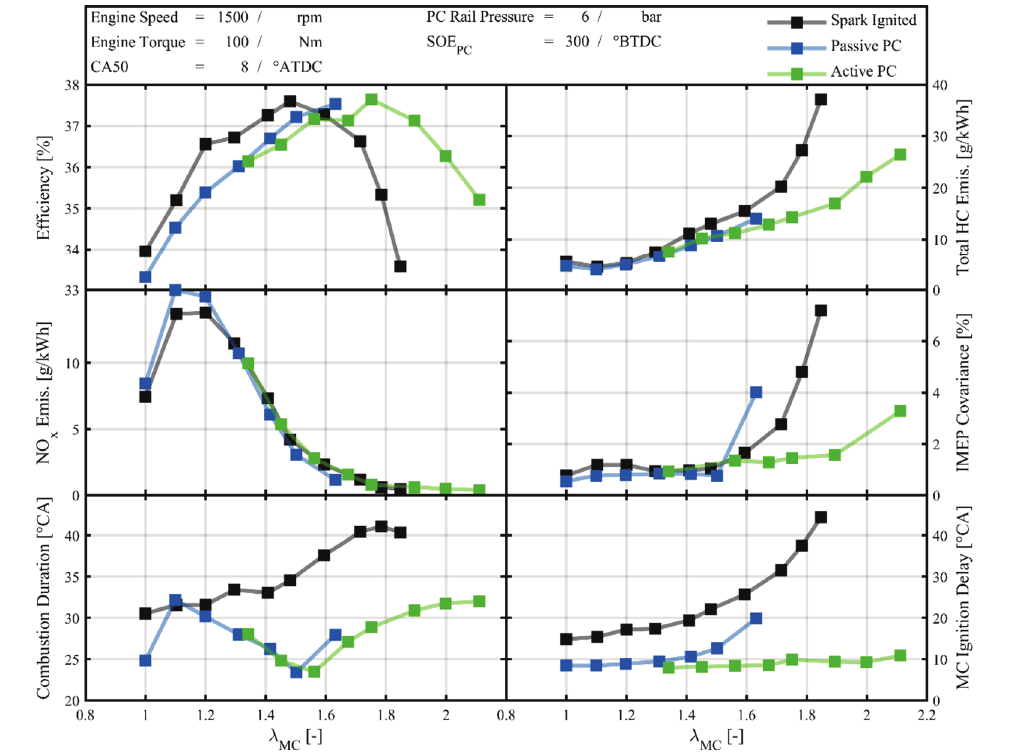
Fig. 8. Air to-fuel ratio variation at a medium load operating point with the spark-ignited engine 1, the pre-chamber engine 2 without scavenging (passive PC) and engine 2 with scavenging (active PC) 1 . 1 Efficiency and emission values presented in this figure are measured with a different piston shape and pre-chamber shape compared to other results stated within this paper. Absolute values are not comparable to other